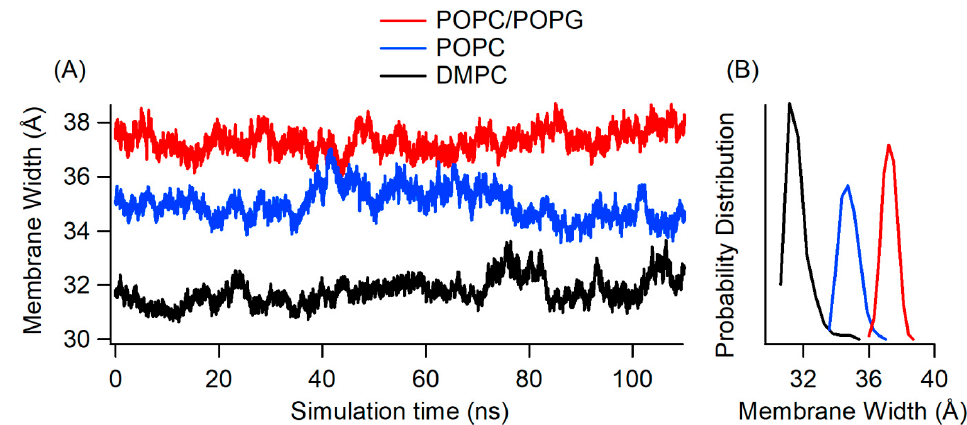
Figure 5. Membrane bilayer width incorporating KCNE3 protein as a function of simulation time ( A ) and membrane width probability distribution ( B ) for POPC/POPG (Red), POPC (Blue), and DMPC (Black) bilayers.